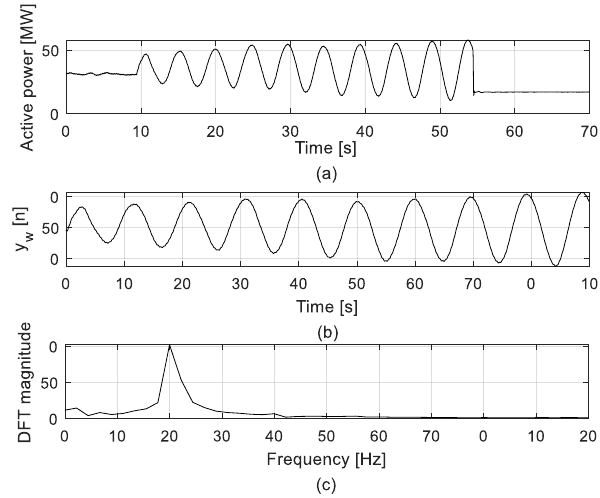
Figure 7. Modal oscillations in the active power of the Central American power system: ( a ) PMU data; ( b ) oscillation data for modal identification; ( c ) DFT magnitude of the oscillation data.